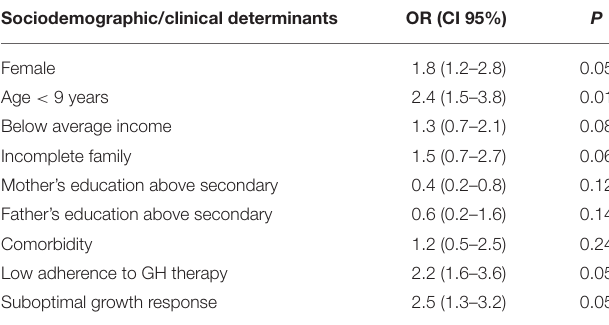
TABLE 4 | The influence of some clinical and sociodemographic determinants on the assessment of internalizing problems in children with GHD. Sociodemographic/clinical determinants